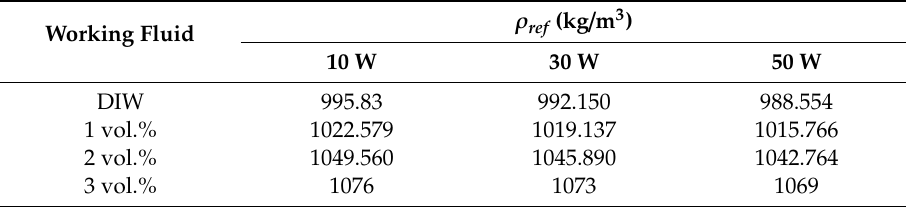
Table A1. ρ ref values of working fluids at di ff erent heater